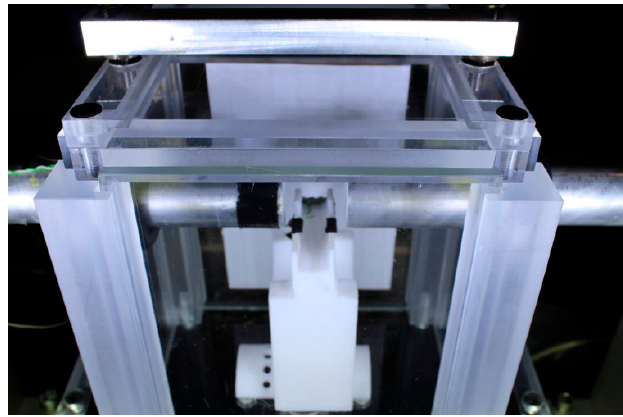
Figure 4. SHPB temperature control chamber made of transparent Plexiglas.